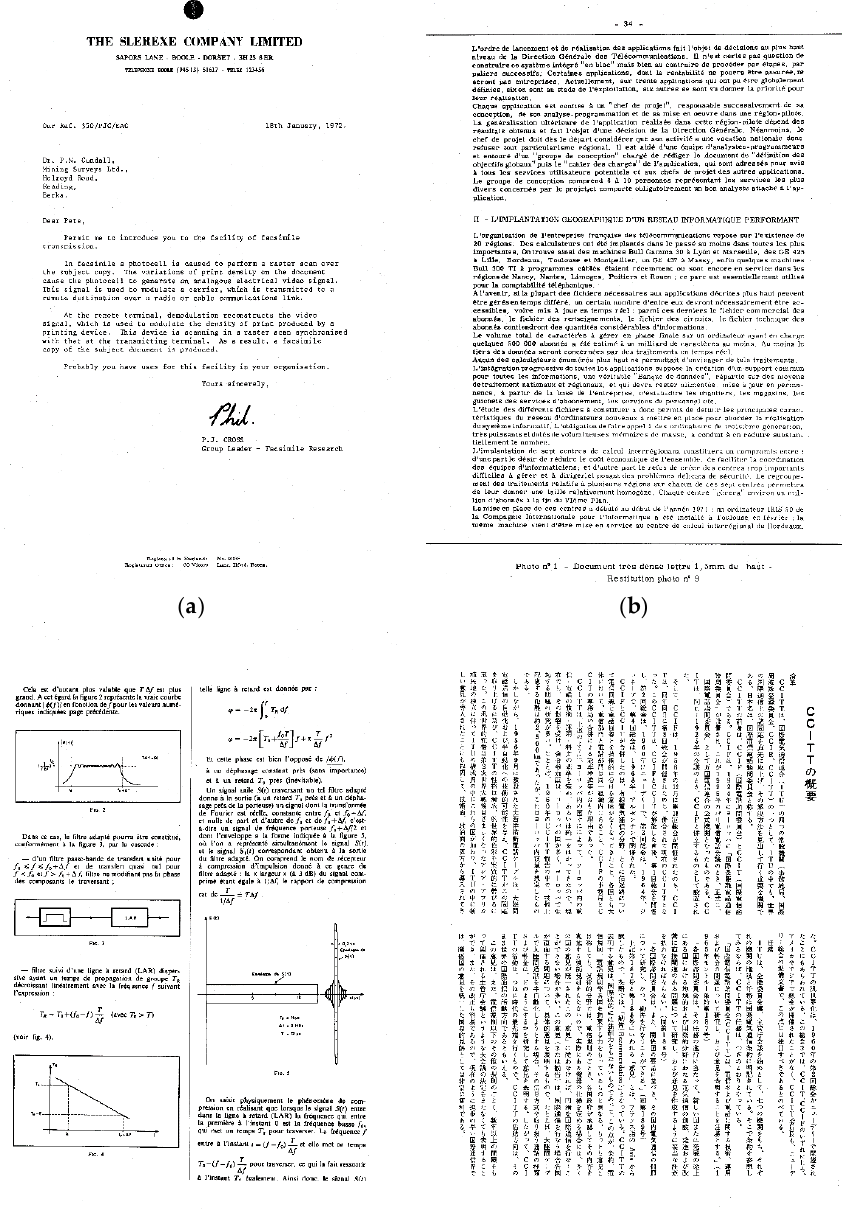
Figure 7. Standard binary images used for simulation. ( a ) CCITT1 document, ( b ) CCITT4 document, ( c ) CCITT5 document, ( d ) CCITT7 document.